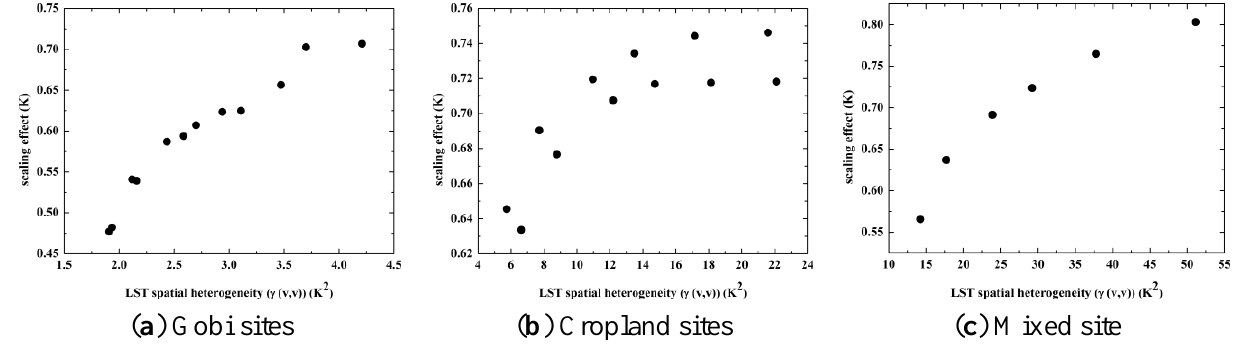
Figure 6. The relationship between spatial heterogeneity of the LST quantified by the dispersion variance 𝛾(𝑣, 𝑣) and the scaling effect in ( a ) the sites covered by Gobi (Sites 1 and 2); ( b ) the sites covered by cropland (Sites 3 and 4); and ( c ) the mixed site (Site